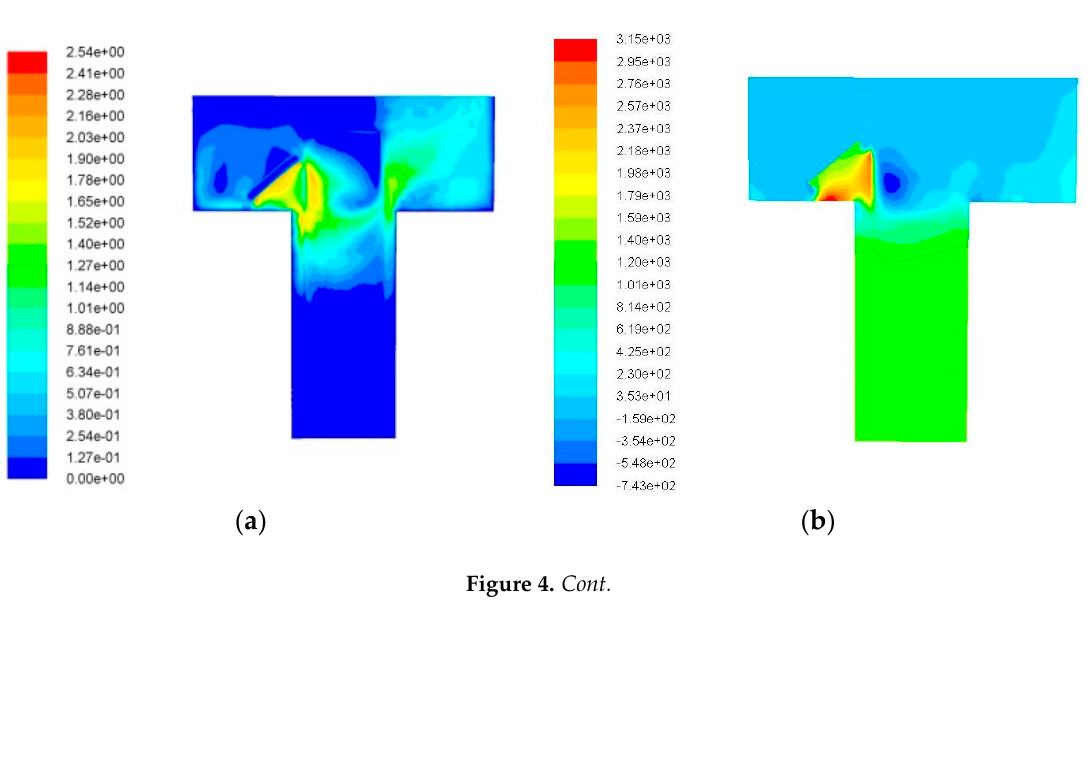
( c ) Figure 4. Machining without ultrasonic vibration. ( a ) Velocity field; ( b ) Pressure field; and, ( c ) Debris distribution. It is shown in Figure 4a,b that, due to the side flushing action, a gap flow field is generated in which the fluids from the left gap near the flush inlet flow to the lower gap and then to the right side gap and at last flow out of the processing area. The highest fluid velocity of 2.54 m/s appears at the wall opposite to flushing direction. The fluid velocity of right side outlet is lower than that of left side inlet. The fluid velocity declines with the increase of hole depth. The highest pressure 3150 Pa appears at the inlet and the negative pressure zone also appears near the inlet, as shown in Figure 4b. However, due to the deep depth of the processing hole, the high speed working fluids formed by the flushing fluid cannot reach to the bottom effectively, and it can be found that the velocity of working fluids in the bottom gap is approximately 0 m/s. Therefore, it could be said that the side flushing has little effect on the debris removal in the case of deep hole machining. It is shown in Figure 4c that, after machining for a while, the debris are gathered together at the lower right corner and can not be removed from machining gap under the condition of side flushing without ultrasonic vibration. That is because the hole depth of machining is large, as the depth increases, the machining gap becomes a long narrow strip and the flowing resistance increases. It is hard for the flushing liquid to arrive at the bottom gap against resistance. This plays a weak role for debris movement of bottom gap, which results in the accumulation of debris and may cause the phenomenon of the arc discharge or short circuit.